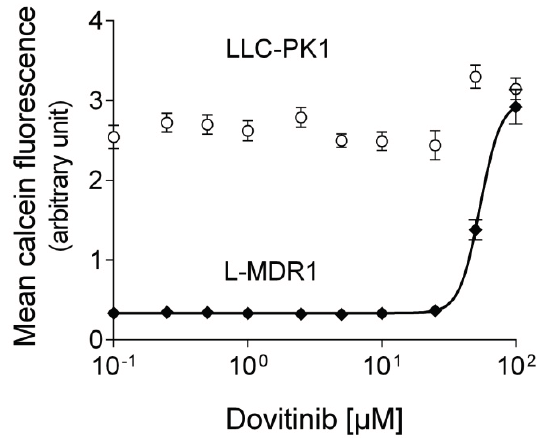
Figure 1. Calcein assay. Concentration-dependent effect of dovitinib on baseline calcein fluorescence in L-MDR1 cells and lack of effect in the corresponding parental cell line LLC-PK1 indicating P-gp inhibition by dovitinib. Each curve depicts one representative experiment of a series of 3. Data are expressed as mean ± SEM for n = 8